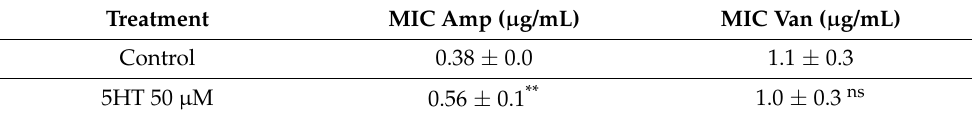
Table 1. Antibiotic susceptibility. E. faecium NCIMB10415 treated with 50 µ M 5HT modifies